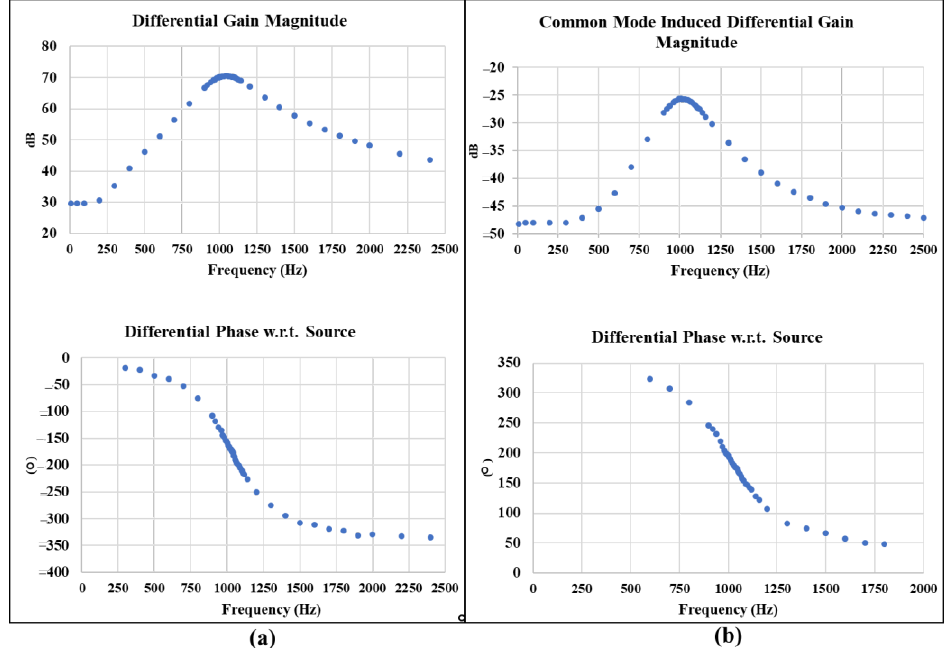
Figure 11. The amplification and filtering board characterization for differential gain magnitude and differential phase verifies a center frequency of 1.02 kHz, bandwidth of 265 Hz, and a differential gain magnitude of 3330.33 𝑣/𝑣 corresponding to 70.44 dB ; ( a ). Maximum common mode induced differential gain magnitude is verified at − 25.7 dB , which yields a total CMRR of 96.14 dB ; ( b ).